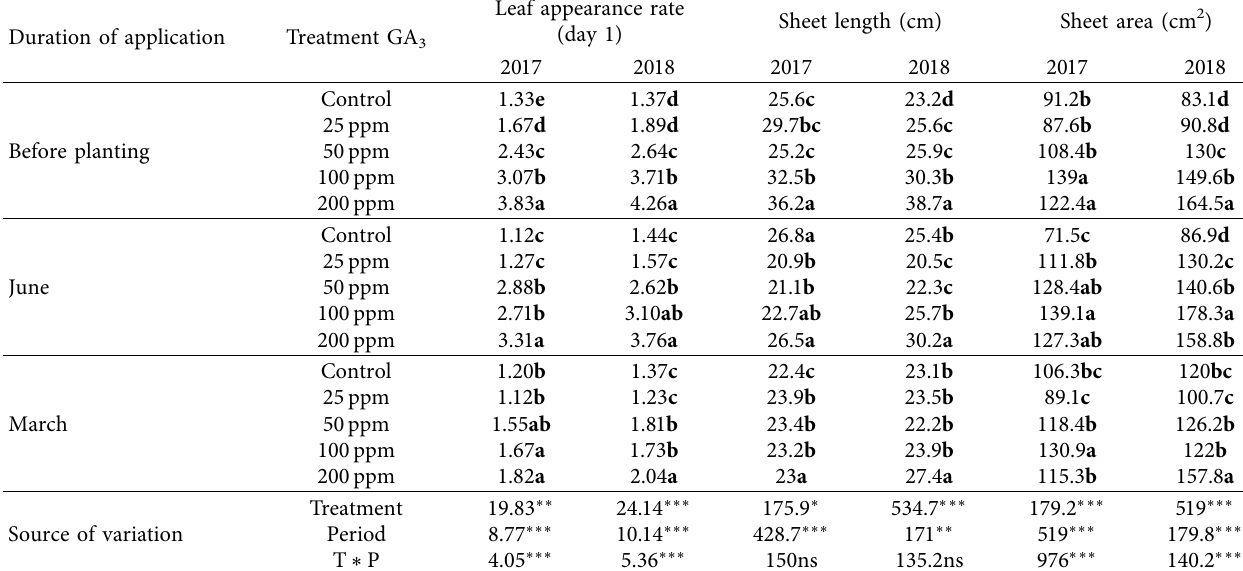
Table 4: Effect of different GA 3 concentrations and duration of application on leaf emergence rate, leaf length, and leaf area. Values with the same letter in each application period in the column are not significantly different ( p � 0 . 05); ns: not significant; ∗ significant at 5%; ∗∗ significant at 1%, ∗∗∗ significant at 1‰.